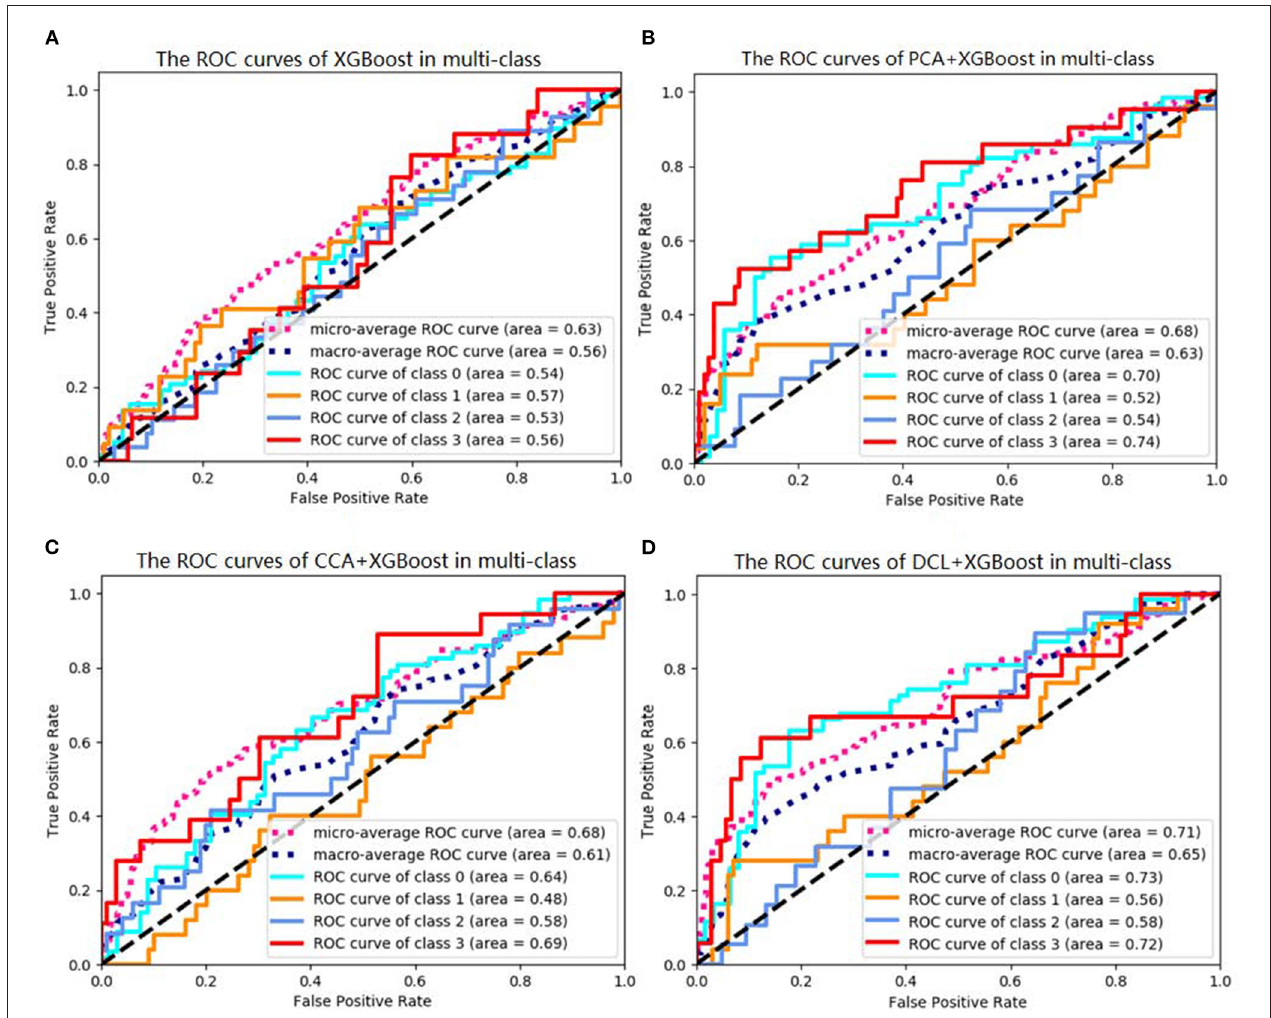
FIGURE 2 | Receiver operating characteristics (ROC) curves of XGBoosts with different pretreatment methods. (A) XGBoost method is used in classification task. (B) The PCA-based XGBoost is used in classification task. (C,D) CCA and DCL-based XGBoosts are used in classification task.